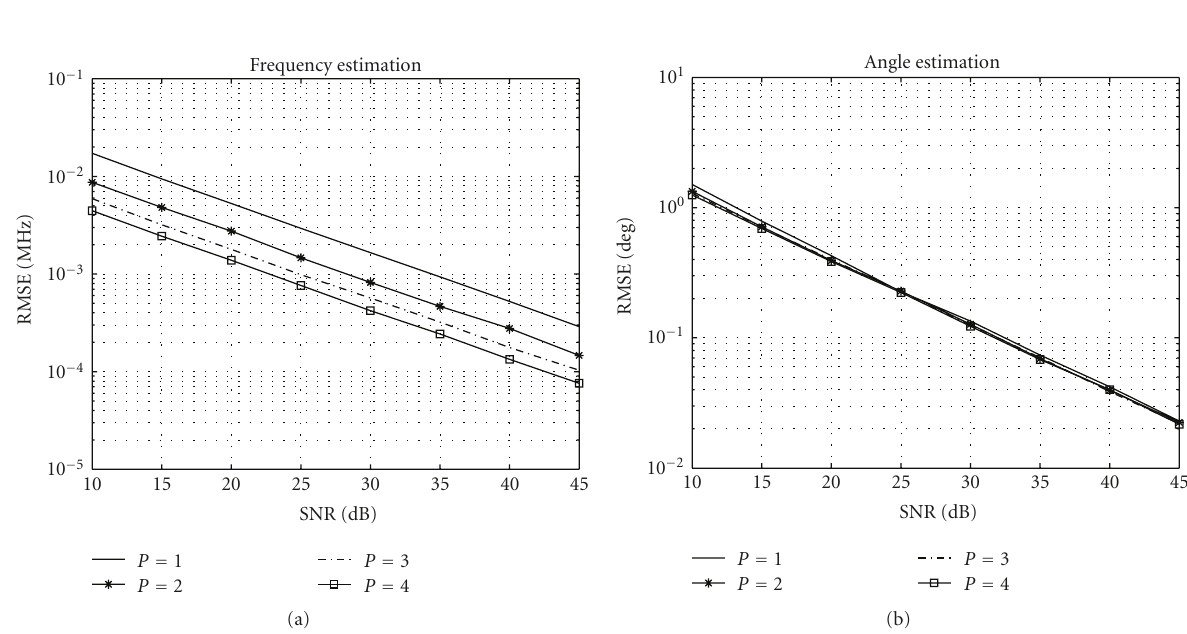
Figure 7: Angle-frequency estimation with di ff erent antennas.